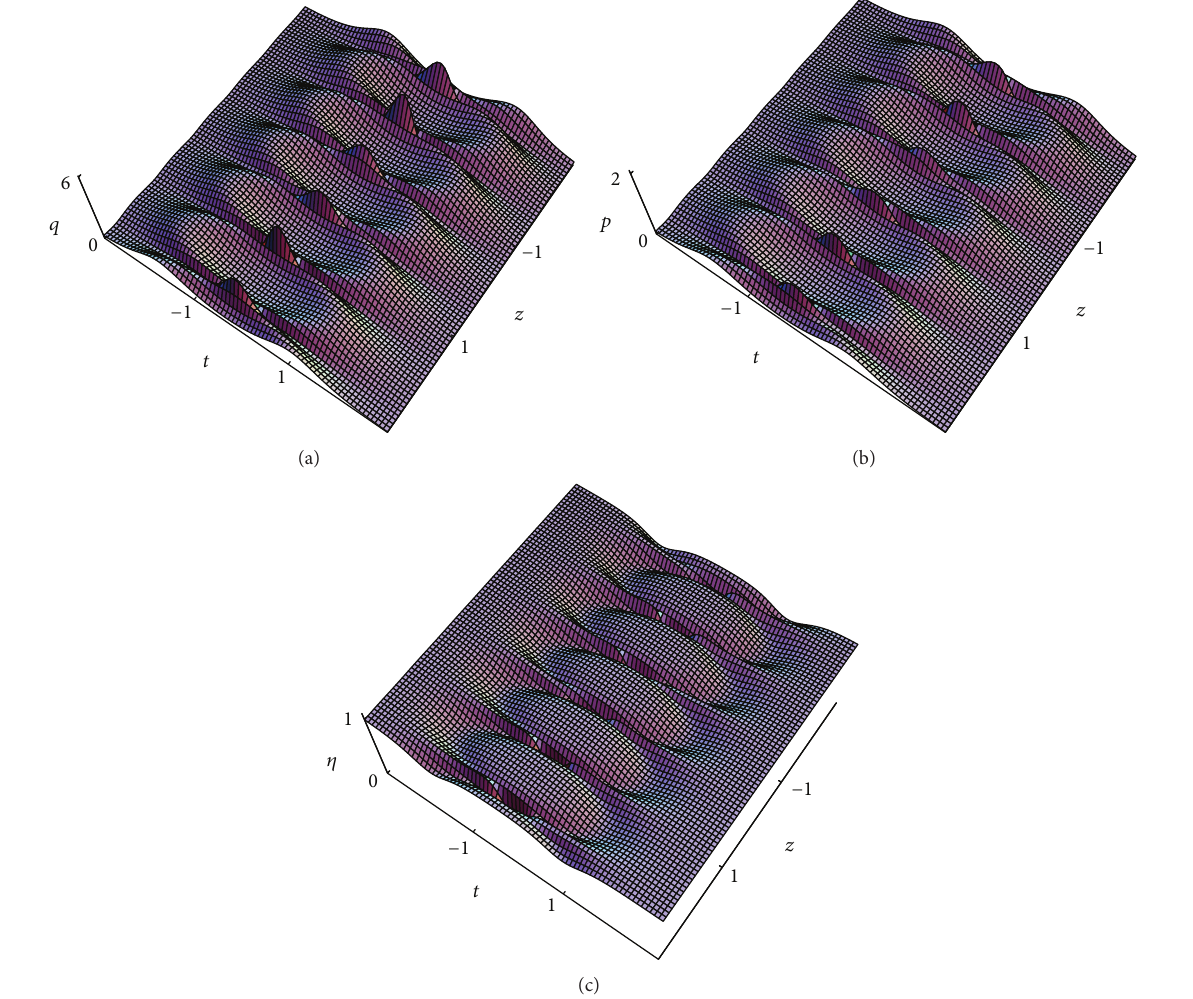
Figure 6: The parameters adopted here are 𝑡 0 = 3 , 𝜔 = 3 , and 𝜏 = 5